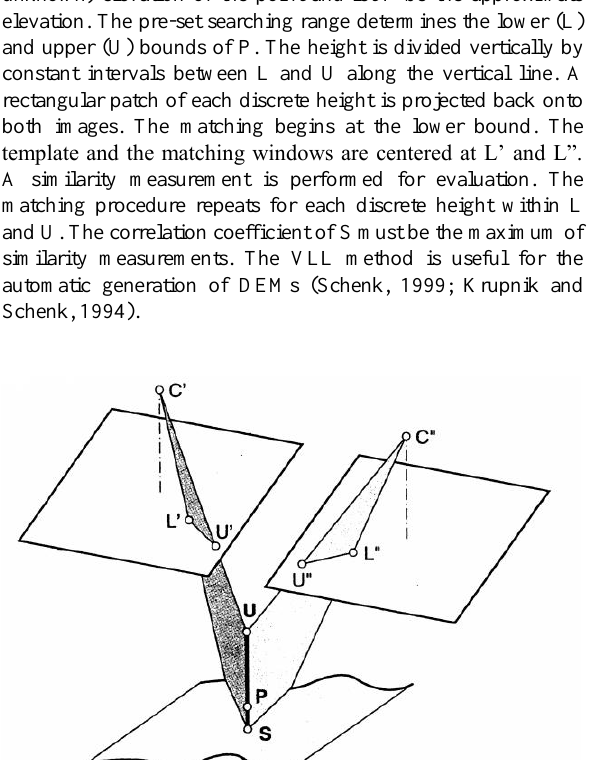
Figure 6. The principle of object-space multi-image matching of MMS image